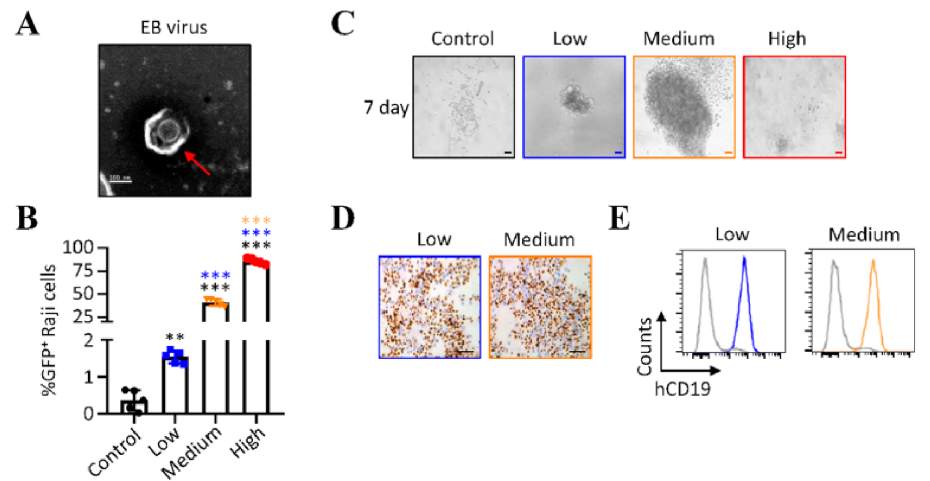
Figure 1. Quantitation of virus titers and infection of primary B cells. ( A ) Transmission electron microscopy (TEM) image of suspensions of EBV (magnification: 25,000 × ). Scale bar = 100 nm. ( B ) The different infectious doses of EBV were quantitated by GFP expression of Raji cells infected with defined volume of the virus. High, medium, and low represent 8.5 × 10 3 , 4 × 10 3 , and 1.5 × 10 2 GRUs of Akata-EBV-GFP, respectively. Mean ± SD, n = 5, ** p < 0.01, *** p < 0.001. ( C ) Seven days after the primary B cells infected with different infectious doses of the virus (low, medium, and high), and the outgrowth detected by microscopy. Scale bar = 50 µ m. ( D ) Four to five weeks after infection, the presence of EBV in the outgrowth was determined by EBV-encoded small RNA (EBER) in situ hybridization. Scale bar = 50 µ m. ( E ) Four to five weeks after infection, flow cytometry analysis of this outgrowth showed CD19-positive B